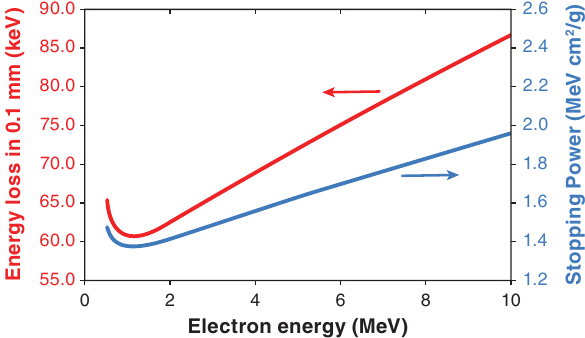
FIG. 7. Stopping power (blue) [27] and calculated energy loss (red) in titanium as a function of electron